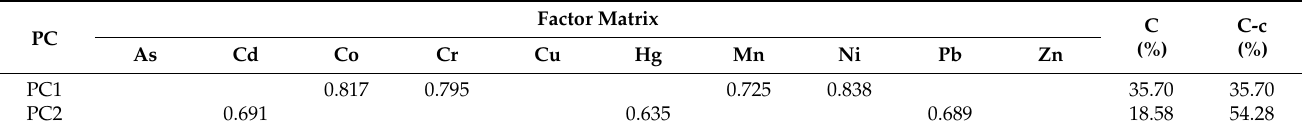
Table 4. Factors matrix of metal elements in